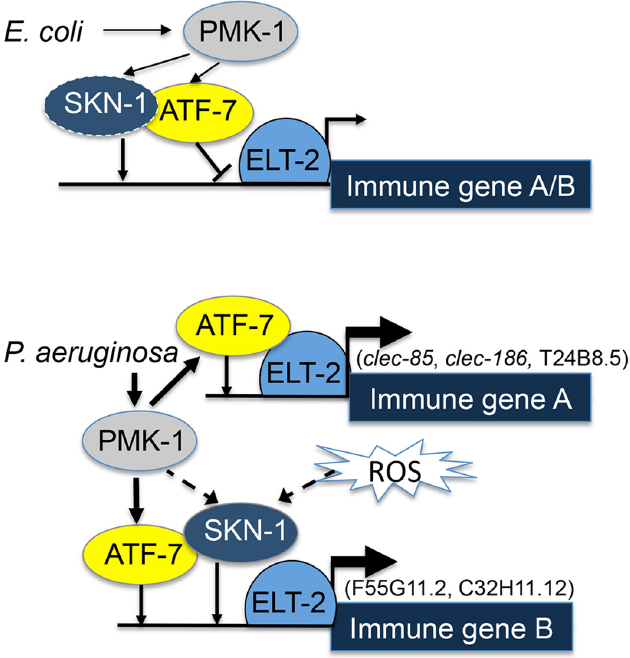
Fig 5. ELT-2-PMK-1-ATF-7-SKN-1 interactions in gene regulation. A model . Solid lines represent interactions suggested by results (line thickness is proportional to degree of activation). Dashed lines represent putative alternative